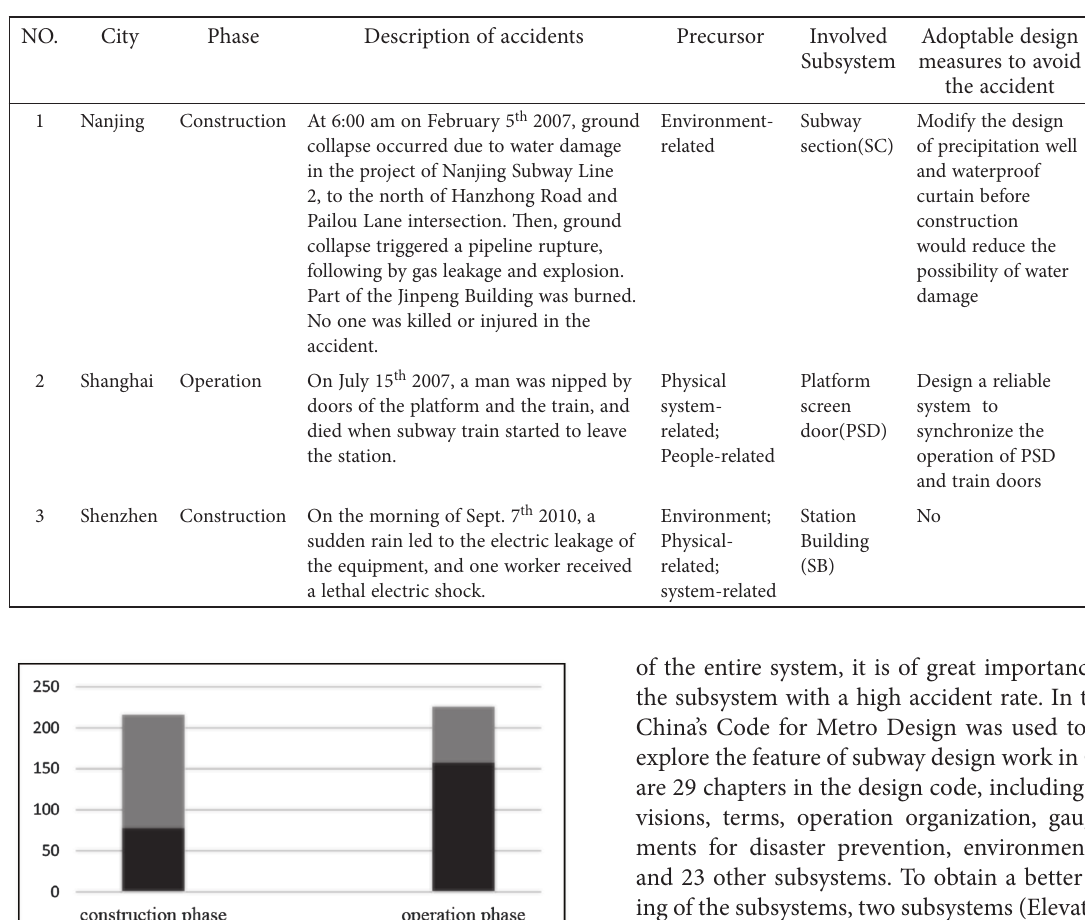
Table 2. Three examples of incident case classification process